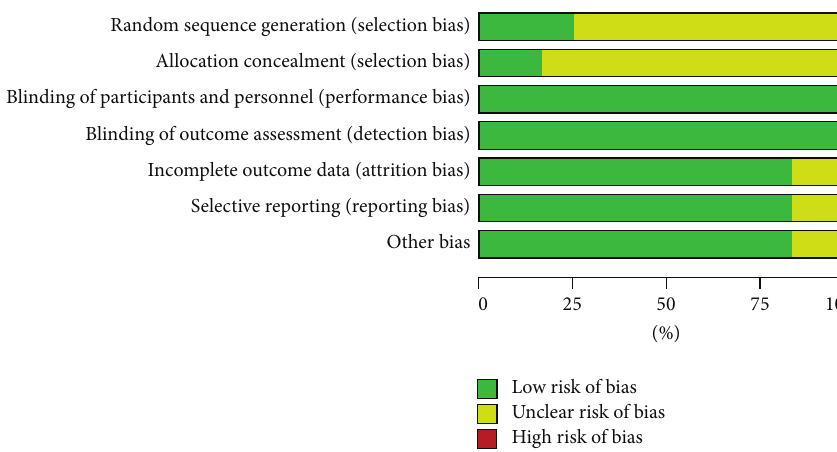
Figure 3: Risk of bias graph: review authors’ judgements about each risk of bias item presented as percentages across all included studies.